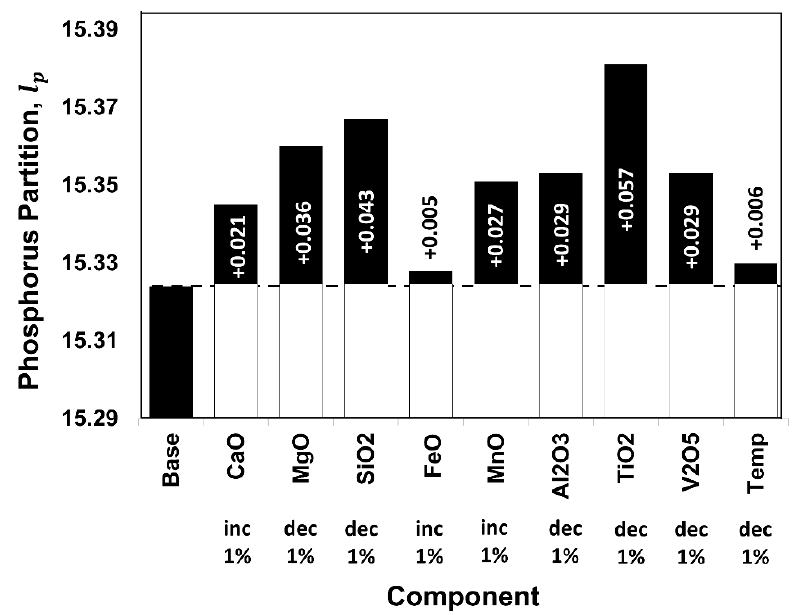
Figure 8. A waterfall analysis of the components in predicting phosphorus partition for plant I.